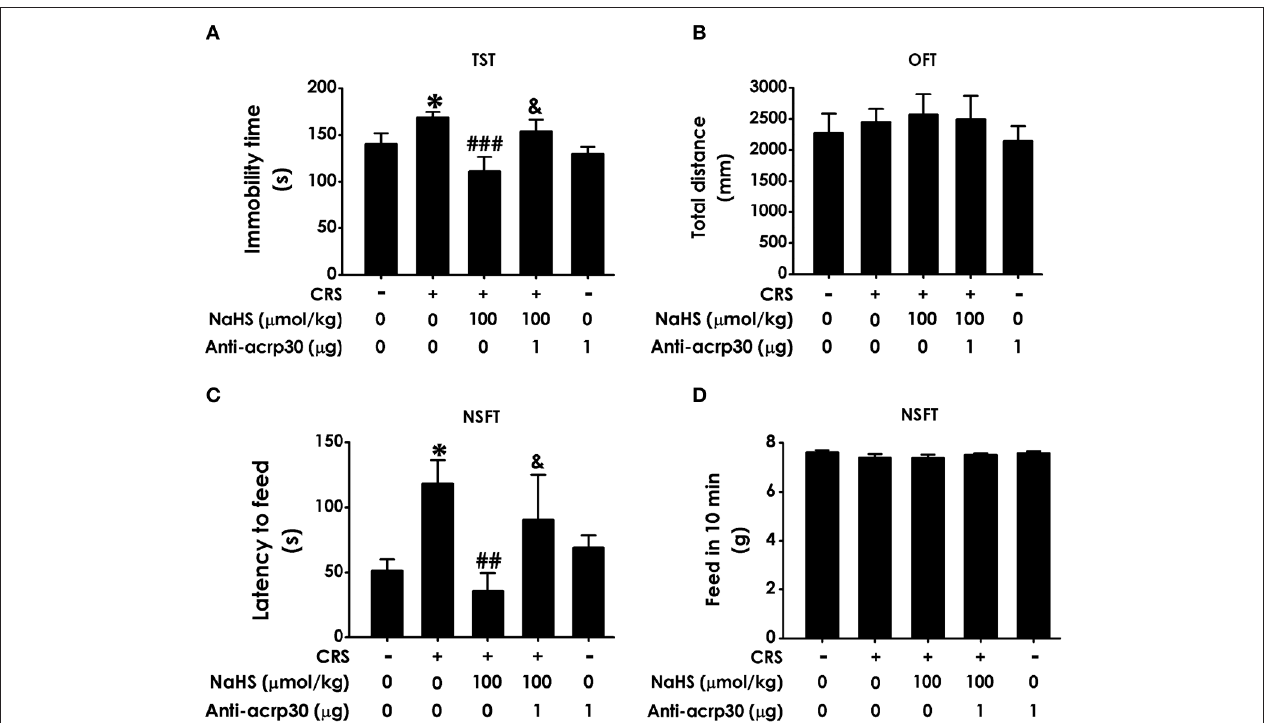
FIGURE 6 | Effect of Anti-acrp30 on H 2 S-elicited antidepressant-like function in CRS-exposed rats. After cotreatment with CRS and NaHS (100 µ mol/kg, i.p.) for 3w, SD rats were further co-administrated with Anti-acrp30 (1 µ g/d, icv) for 1w. TST (A) , OFT (B) , and NSFT (C,D) were employed to assess depressive-like behaviors. Values are expressed as means ± SEM ( n = 6–10). * P < 0.05, vs. control group; ## P < 0.01, ### P < 0.001, vs. CRS-treated alone group, & P < 0.05, vs. cotreated with CRS and NaHS (100 µ mol/kg, i.p.)